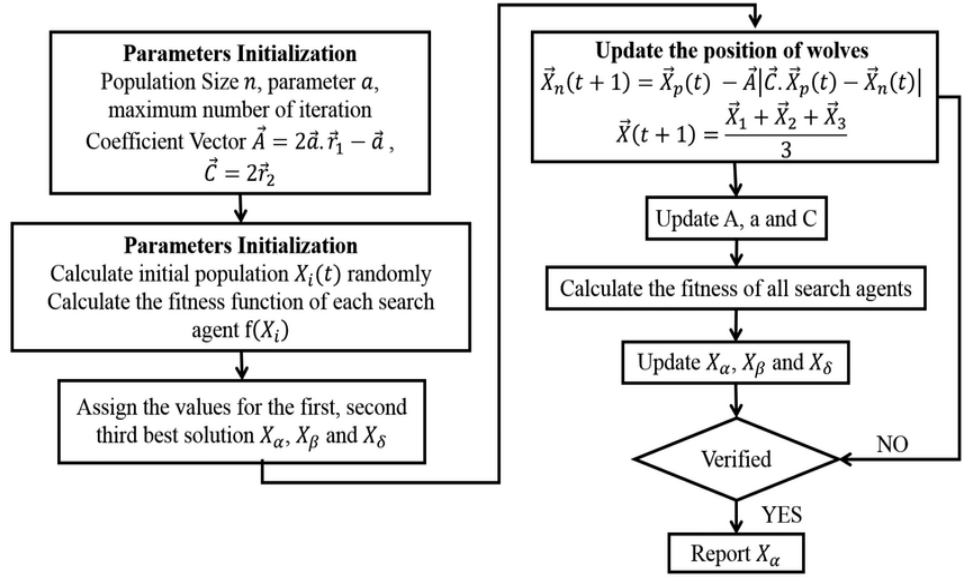
Figure 7. Flowchart of Gray Wolf